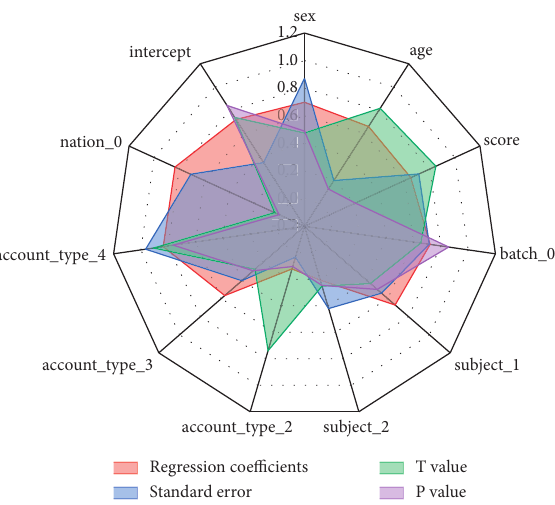
Figure 7: Regression